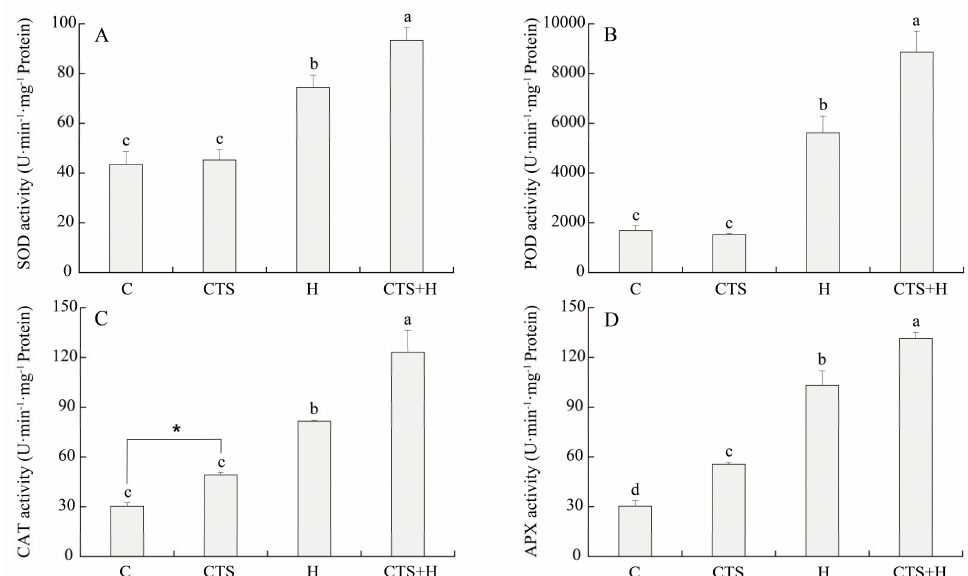
Figure 6. Effect of chitosan on ( A ) superoxide dismutase (SOD), ( B ) peroxidase (POD), ( C ) catalase (CAT), and ( D ) ascorbate peroxidase (APX) activities under control and heat stress conditions. Vertical bars above columns indicate ± standard error (SE) of means ( n = 4) and different letters above columns indicate significant differences among treatments ( p ≤ 0.05).